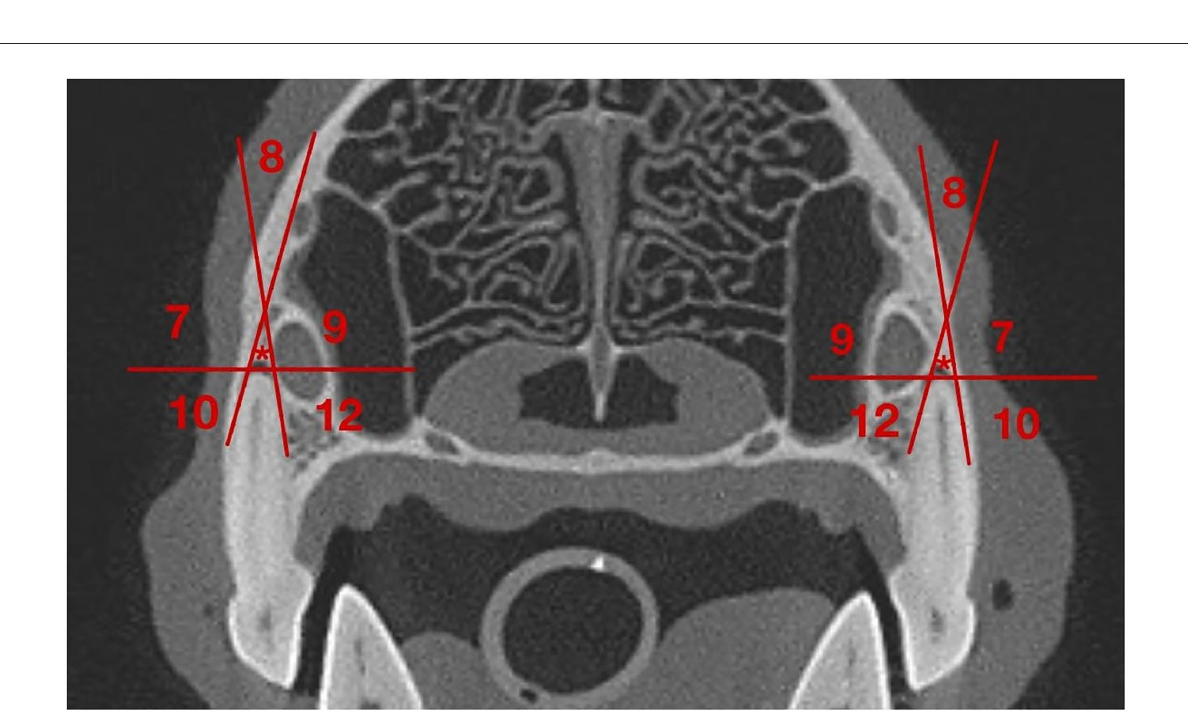
FIGURE2 Grid for the IOC relative to the distal root of the P4. (7) Section 7: Apical and buccal to the distal root; (8) Section 8: Indirectly apical to the distal root; (9) Section 9: Apical and palatal to the distal root; (10) Section 10: Directly buccal to the distal root, ( * ) Section 11: Directly apical to the distal root; (12) Section 12: Directly palatal to the distal